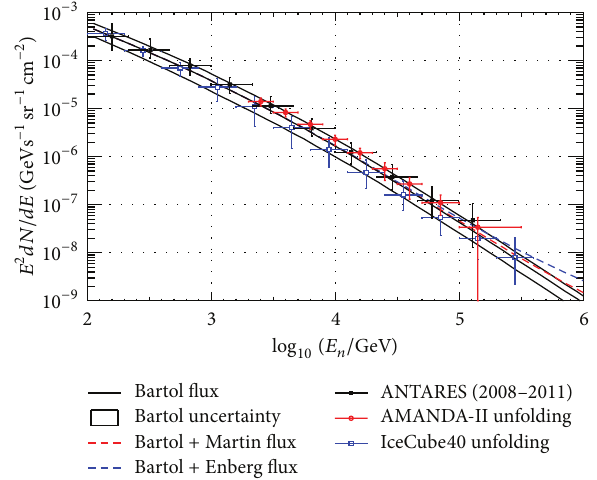
Figure 17: Atmospheric muon neutrino spectrum in the 0.1– 200 TeV energy range, measured by ANTARES, AMANDA-II, and IceCube compared with the Bartol, Bartol + Martin, and Bartol + Enberg MC